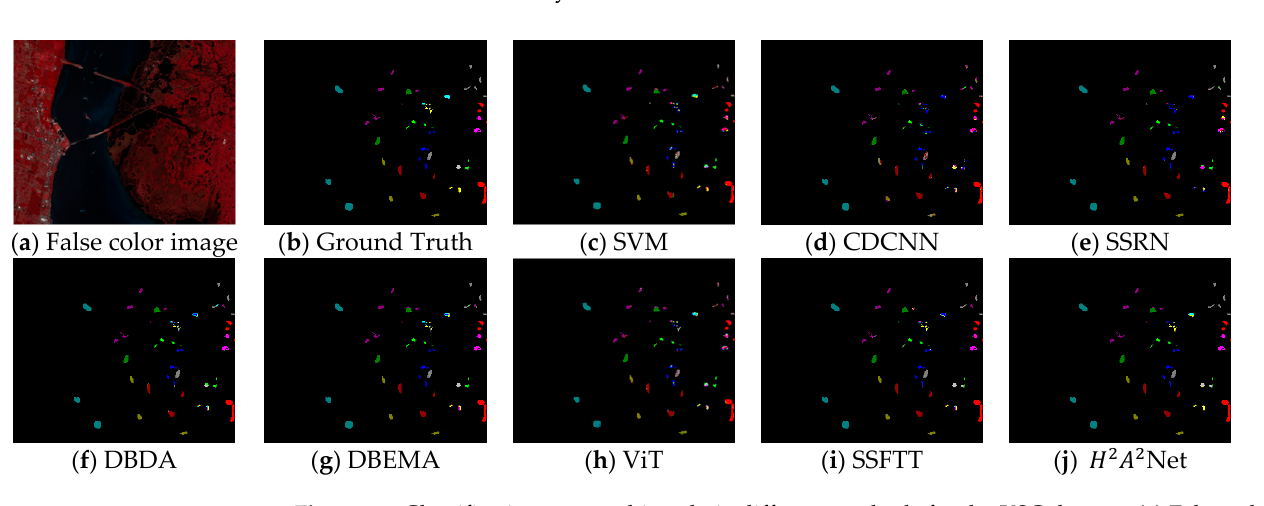
Figure 11. Classification maps achieved via different methods for the KSC dataset. ( a ) False color image. ( b ) Ground Truth. ( c ) SVM (84.11%). ( d ) CDCNN (76.91%). ( e ) SSRN (88.13%). ( f ) DBDA (90.31%). ( g ) DBEMA (94.46%). ( h ) ViT (81.19%). ( i ) SSFTT (92.56%). ( j ) H 2 A 2 Net (96.29%).